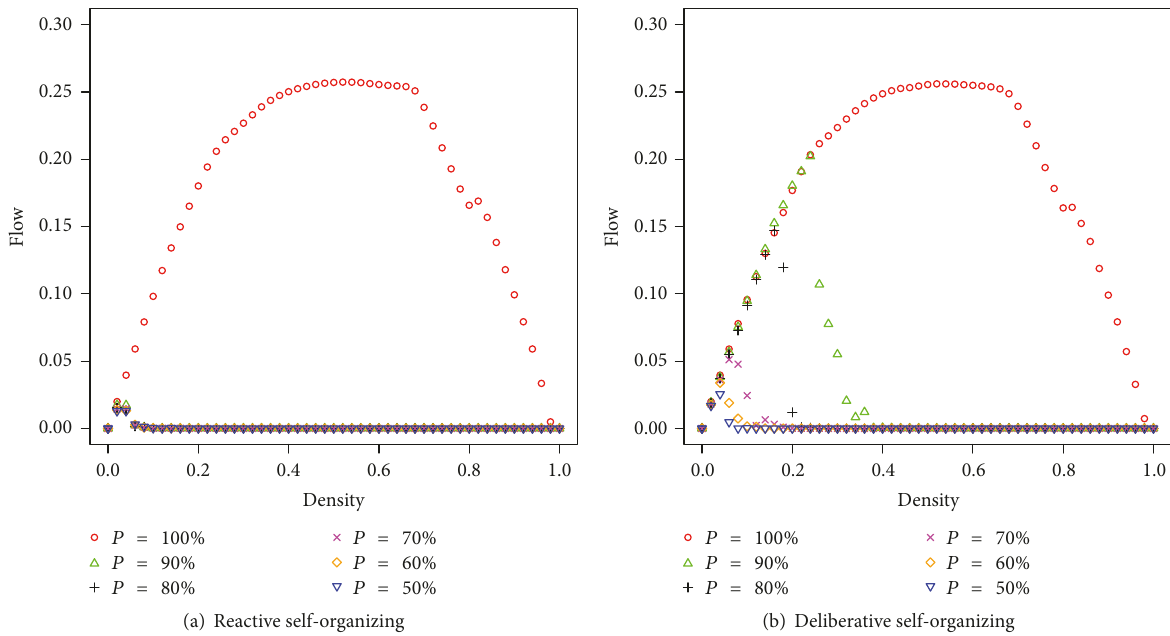
Figure 9: Flow-density diagrams for different error rates. 𝑃 represents the accuracy of the